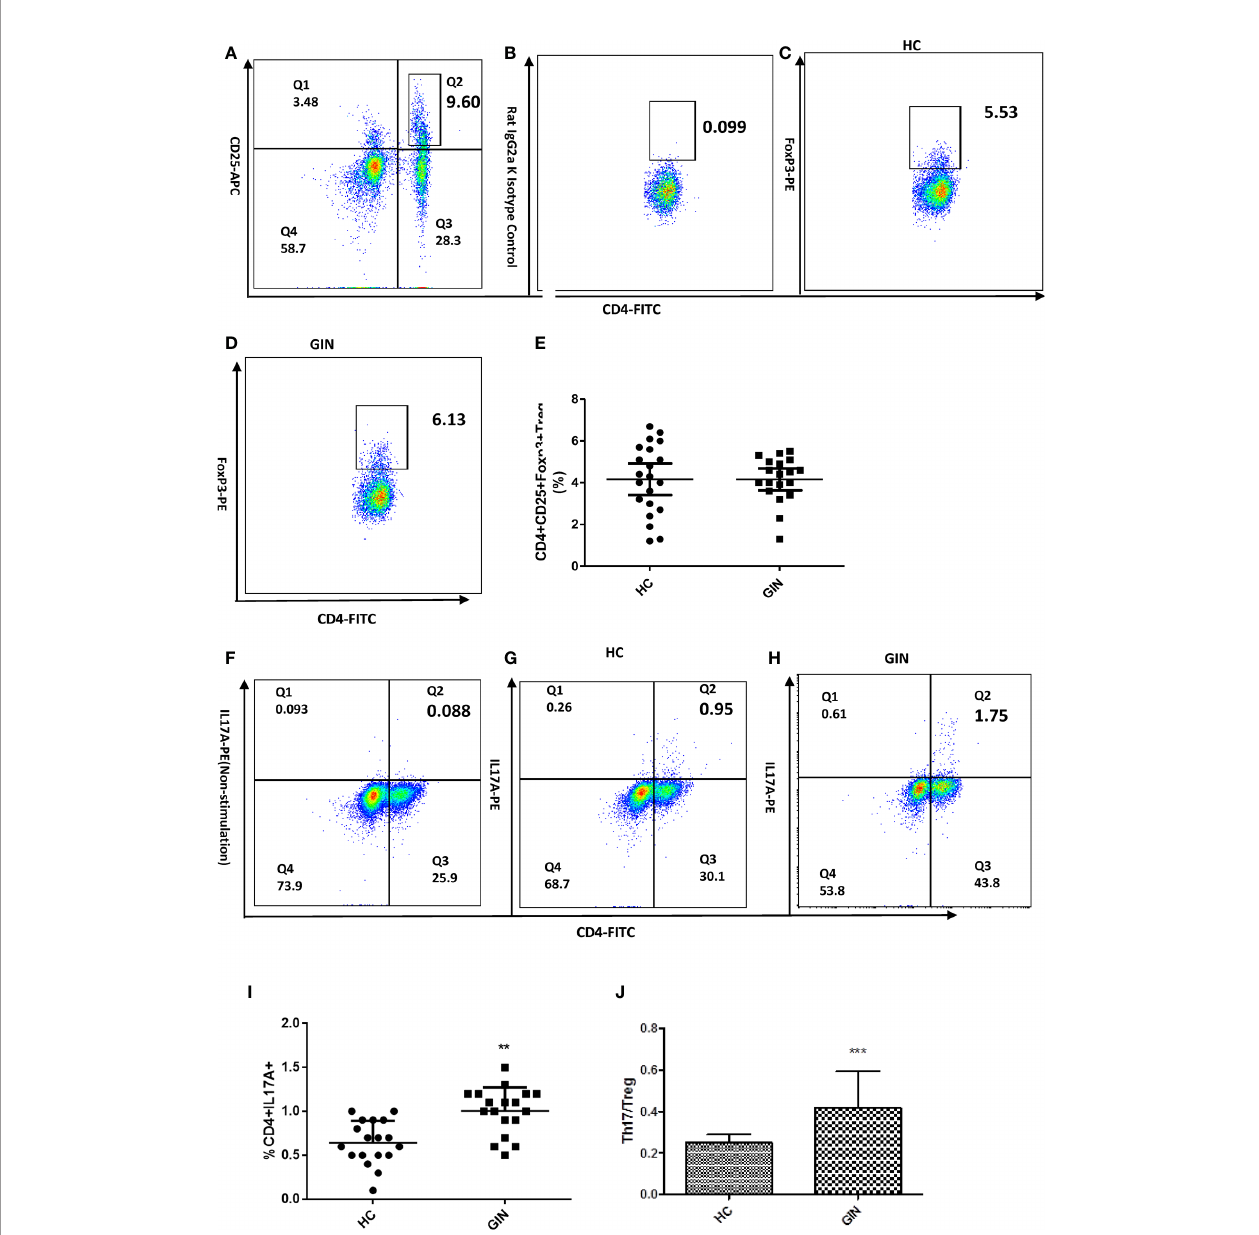
FIGURE 2 | Proportions of CD4+CD25+FoxP3+ Treg and CD4+IL-17+ Th17 cells in gingivitis patients and healthy controls. (A) Dot plot int the upperright quadrant represents CD4+ CD25 + T Cells. (B) Isotype control staining of FoxP3. (C) Dot plot represents Treg cells from a healthy control subject (D) Treg cells from a representative patient with gingivitis. (E) CD4+CD25+Foxp3+Treg percentages. (F) Non stimulation of Leukocyte Activation Cocktail of the Th17 cells in a healthy control .(G) Dot plot in the upper right quadrant represents Th17 cells from a healthy control subject. (H) Th17 cells from a representative patient with gingivitis. (I) CD4+IL-17+Th17 percentages. (J) the ratio of Th17/Tre. Data presented are means ± SD. ** P < 0.01, *** P < 0.001 versus healthy